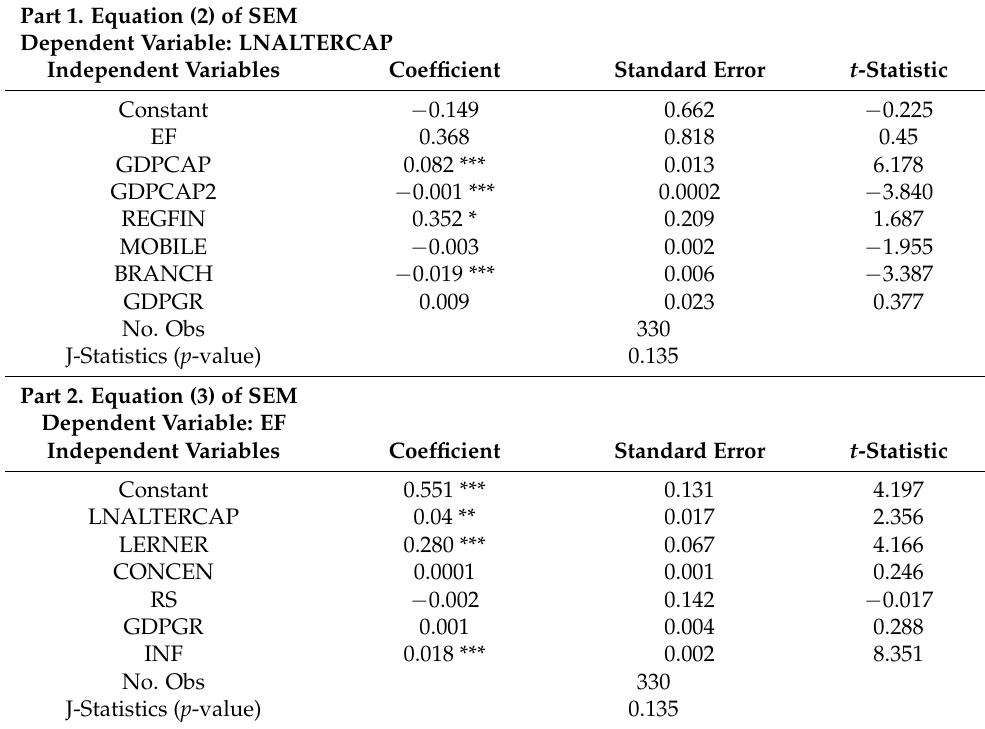
Table 3. Results of second-stage SEM analysis using an alternative measure of fintech